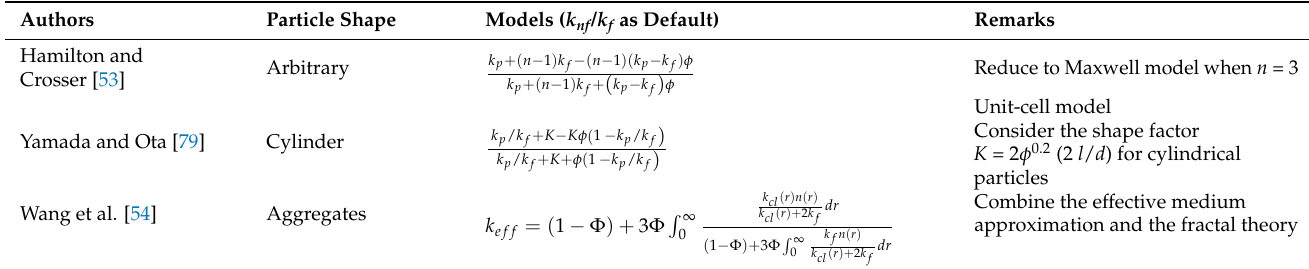
Table 2. Typical models for TCE of NSN